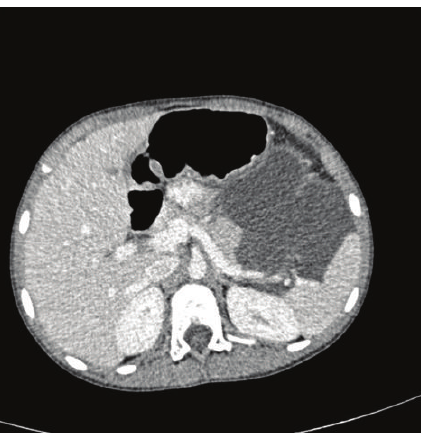
Figure 1: Contrast-enhanced CT axial scan shows retroperitoneal lobulated-septated cystic mass between spleen, stomach, and pan- creas. Splenic vein and artery borders are in the cystic mass. Also cystic mass reaches to the pararenal space.